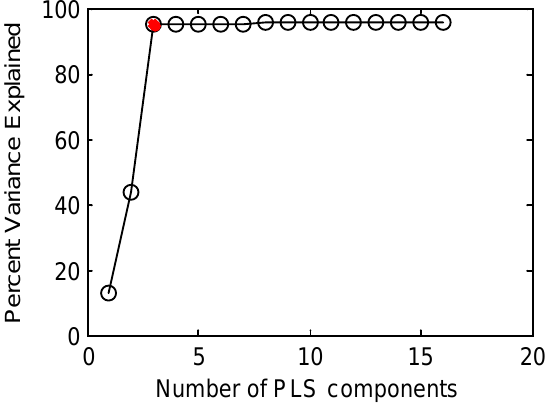
Figure 11. Number analysis of PLS components under fault 7.